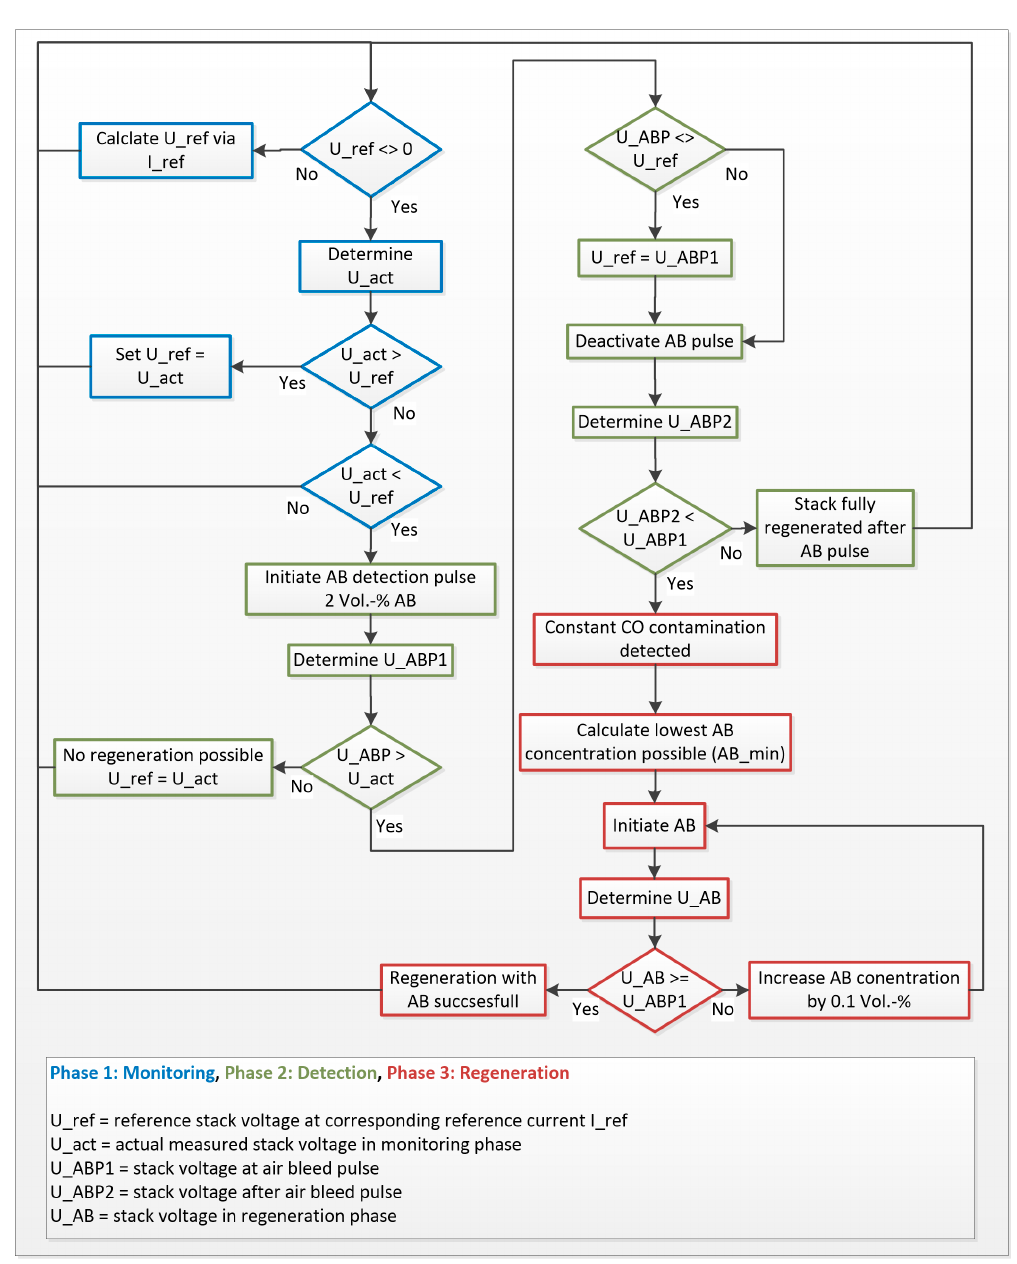
Figure 1. Flow chart of detection and recovery algorithm.